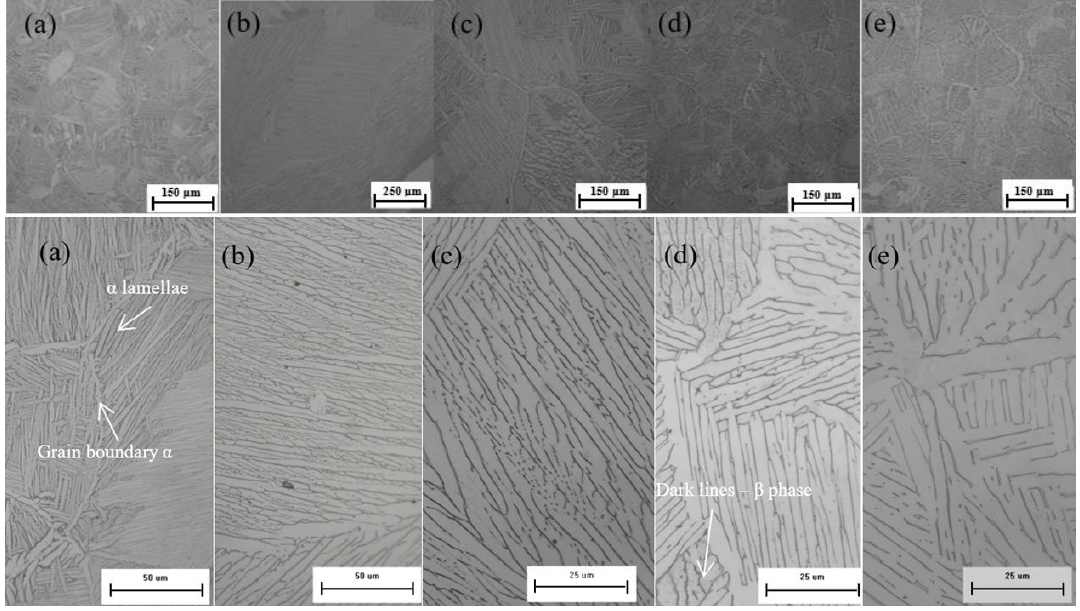
Figure 2. Optical micrograph of powder compact extrusion (PCE)-produced Ti-6Al-4V alloy: ( a ) as-extruded: fine lamellar microstructure; ( b ) 1200 °C/30 min, FC, 730 °C/2 h: coarse lamellar microstructure with a complex structure of α lamellas; ( c ) 1065 °C/1 h, FC, 730 °C/2 h: basketweave structure with partially broken up β phase; ( d ) 955 °C/1 h, FC: fine lamellar microstructure with complex grain and colony structure; ( e ) 925 °C/4 h, CFC@50 °C/h to 760 °C, FC: α laths, interfaces, and the grain boundary layer morphology. Note: the bottom row of images shows the same features at high magnification.